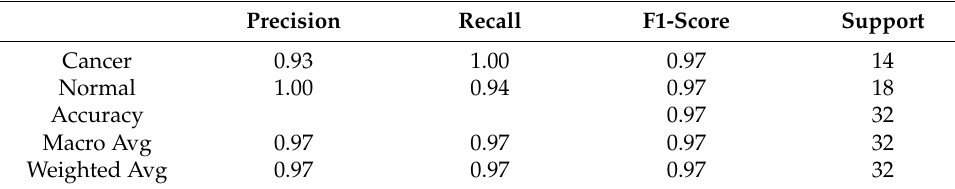
Table 4. The core classification report on the test